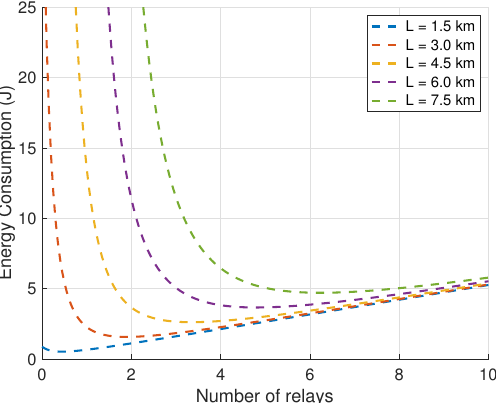
Figure 2. Energy consumption over intermediate hops with different distances L